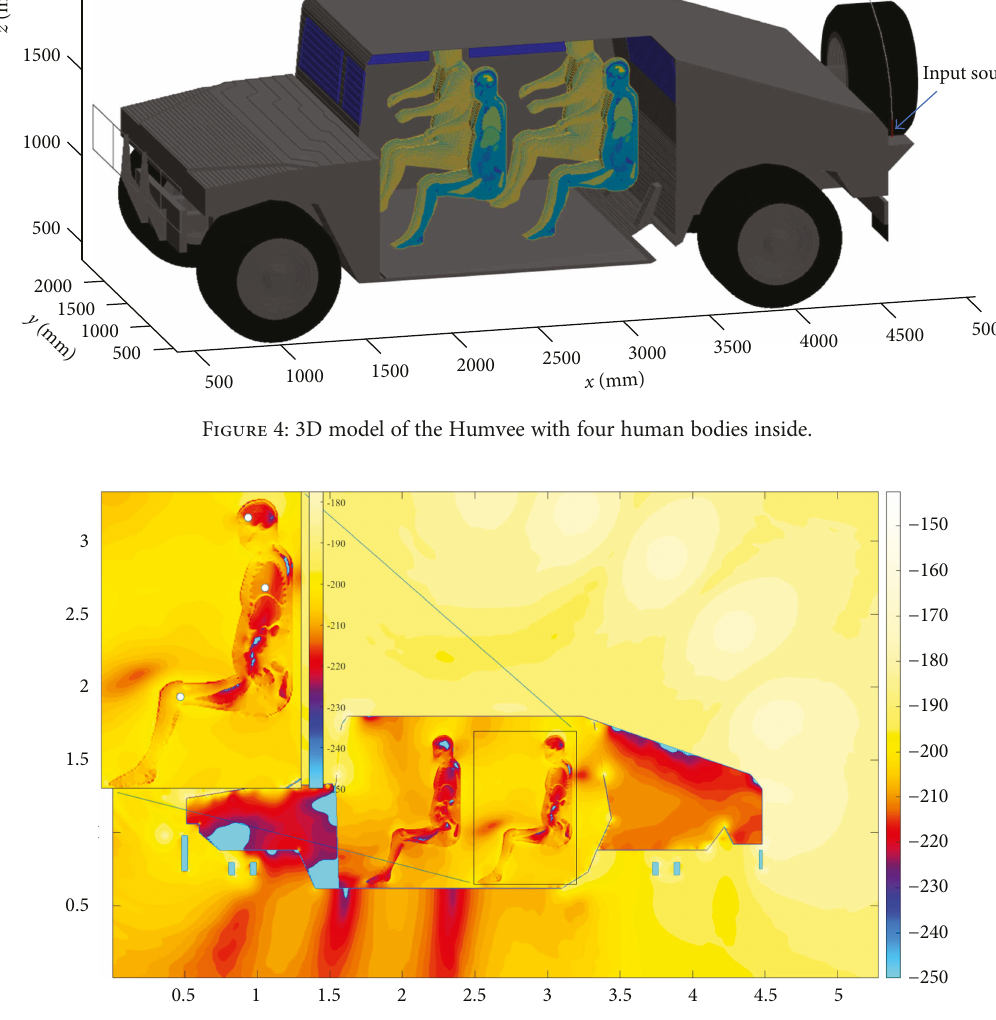
Figure 5: Electric fi eld distribution at the frequency